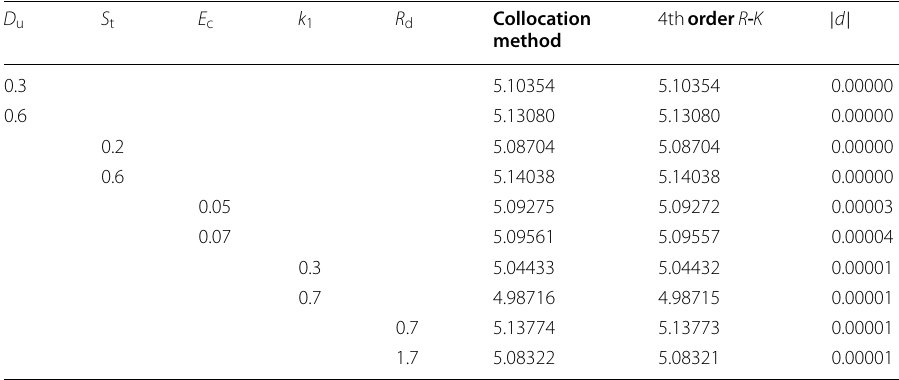
Table 2 Comparison of the collocation method with fourth-order Runge–Kutta method D u S